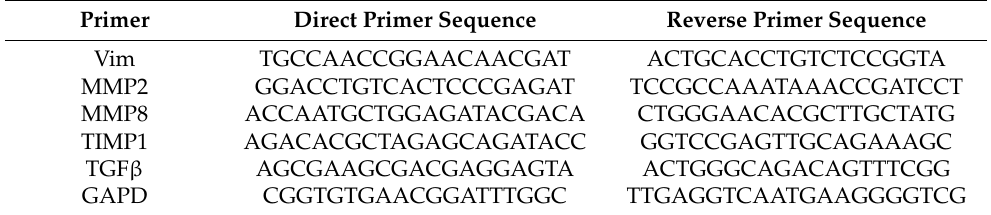
Table 1. Primers for reverse polymerase chain reaction for assessment of fibrotic gene expression.